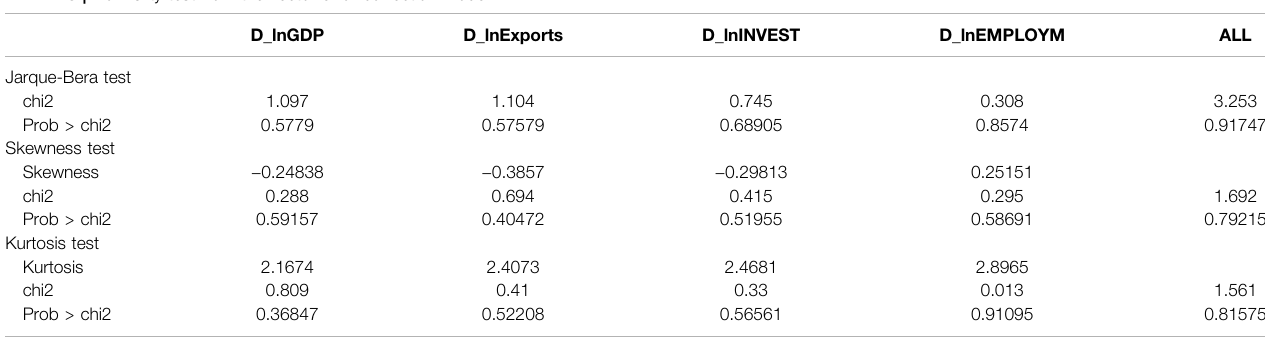
TABLE 8 | Normality test from the vector error correction